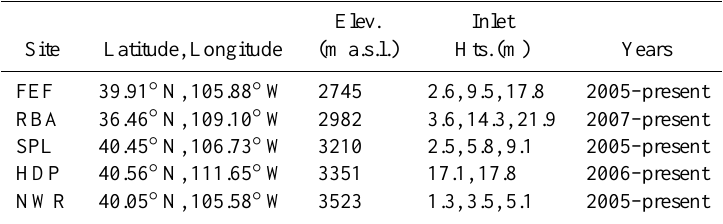
Table 1. Site details. Listed are the site coordinates, elevations in m a.s.l., inlet height, and installation year. All sites are topographically situated on mountaintops except FEF (alpine valley), and NWR (ridgetop). As discussed previously, measurements from FEF are only used in a specific diagnostic test and are otherwise not used.